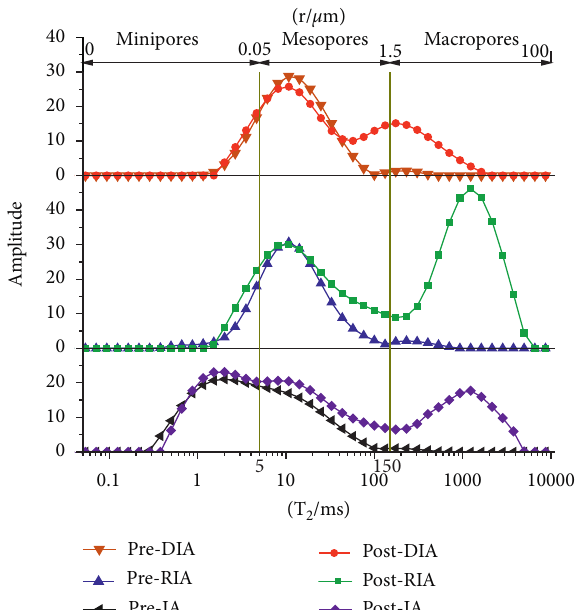
Figure 6: T 2 spectrum distribution under different loading and unloading methods (